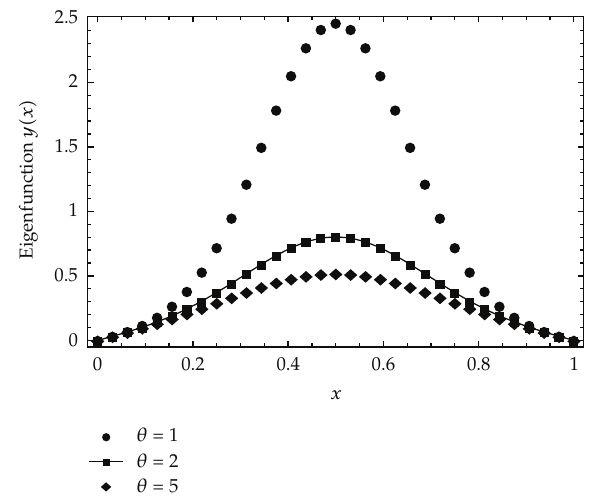
Figure 2: Solutions of Mathieu’s equation for di ff erent parameters of θ